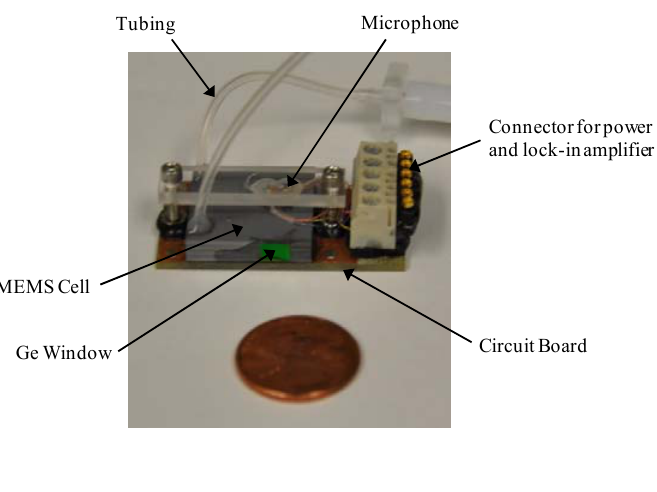
Figure 3. Photograph of the MEMS-scale photoacoustic cell used when collecting